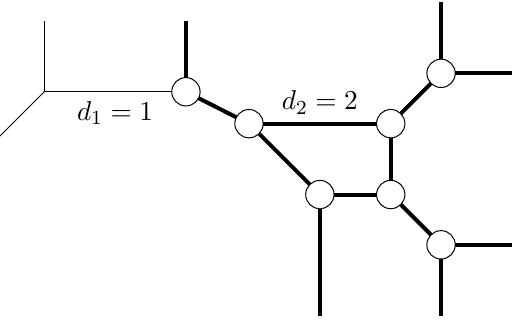
Figure 9 . The web diagram for BC 2 quiver with N f = 0, N 2 = 2 N 1 = N 0